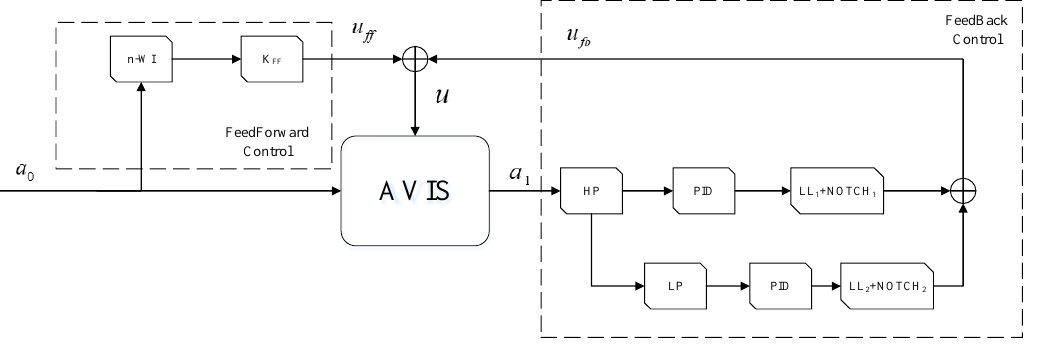
Figure 5. Hybrid control loop diagram of active vibration isolation system. The measured basic platform noise a 0 passes through the n -order weak integrator and control gain K FF , and it forms the feedforward control force u f f . At the same time, the measured load platform noise a 1 passes through the high-low pass filter, PID, lead-phase filter and notch, and it forms the feedback control force u fb . Finally, they synthesize the hybrid control force u to drive the voice coil motor to suppress the noise.